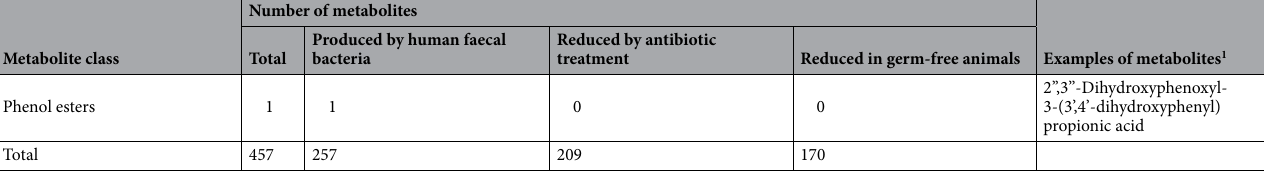
Table 1. Main classes of microbial metabolites in the Exposome-Explorer database and type of evidence supporting their microbial origin. 1 The first three metabolites with larger number of records on experimental evidence.